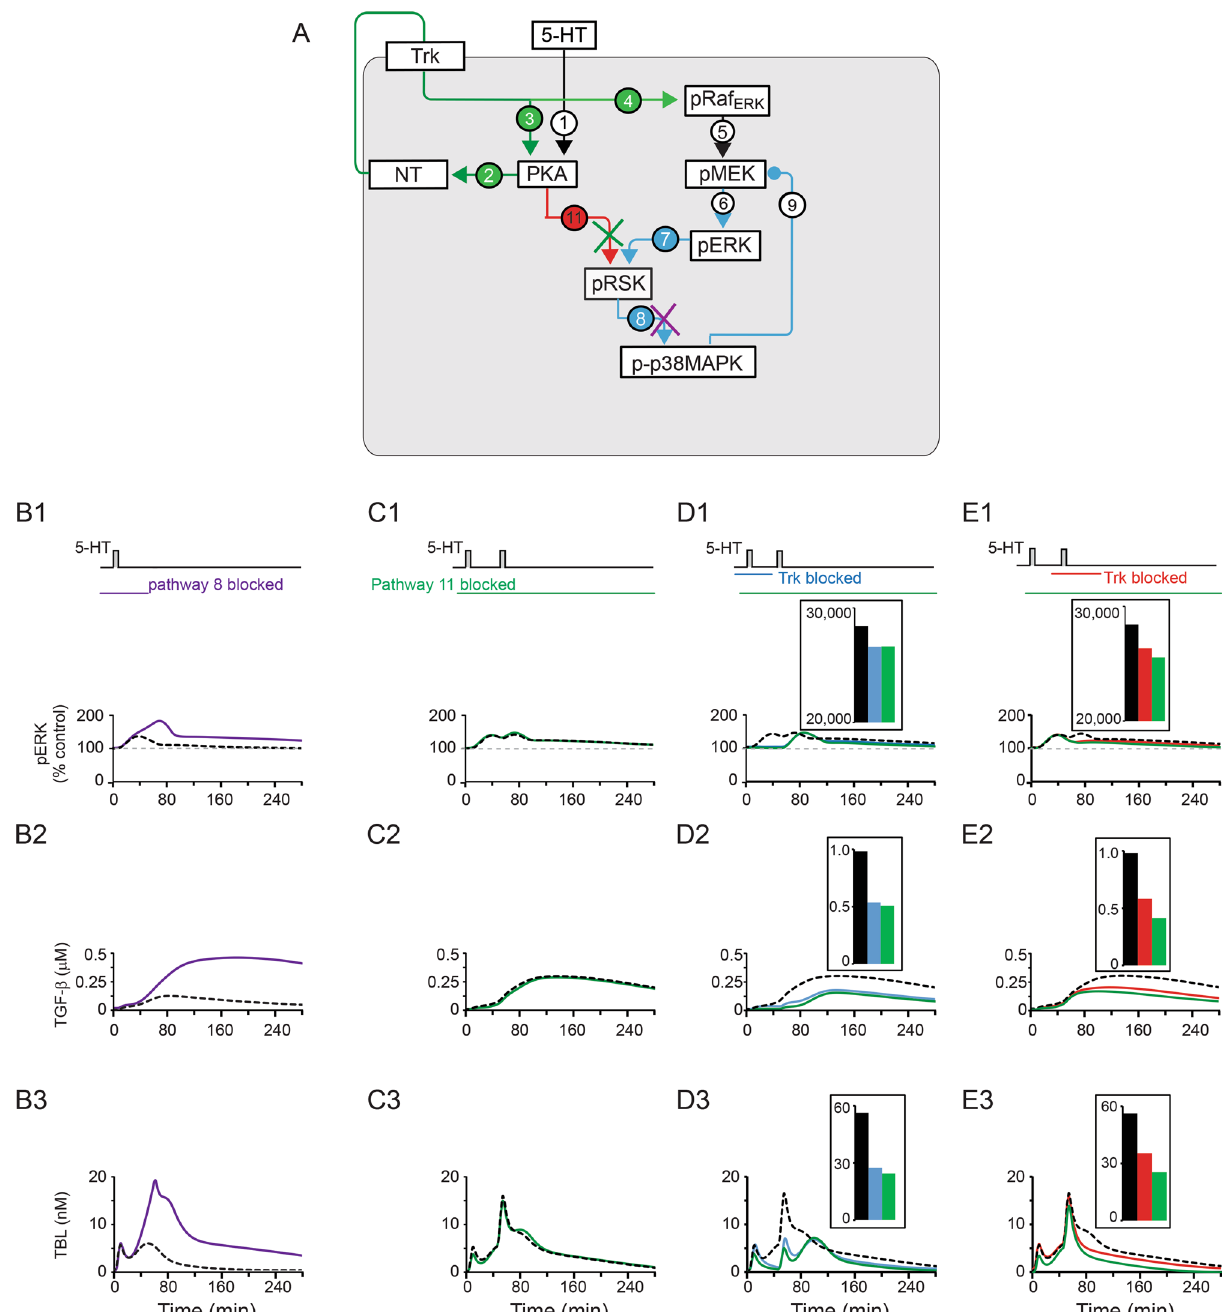
Figure 6. Simulated dynamics of pERK, TGF-β, and TBL after one pulse of 5-HT, with or without suppression of pathway 8 (purple ‘x’) or pathway 11 (green ‘x’) in ( A ). ( B ) Dynamics of pERK, TGF-β, and TBL after one pulse of 5-HT with blocking of pathway 8 (purple curves). Black dashed curves are control simulations with no suppression. ( C–E ) Dynamics of pERK, TGF-β, and TBL after two pulses of 5-HT (ISI = 45 min) with block of pathway 11 in the absence of block of the Trk pathway ( C , green curve), or in the presence of Trk inhibitor during either the first ( D , green curve) or second pulse ( E , green curve) of 5-HT. Also shown are the effects of only blocking the Trk pathway during the first ( D , blue curve) or second ( E , red curve) pulse of 5-HT. Black dashed curves are control simulations. The histograms in boxes in D and E denote the integral values of pERK, TGF-β, and TBL between 50 and 280 min, with bar colors matching the corresponding